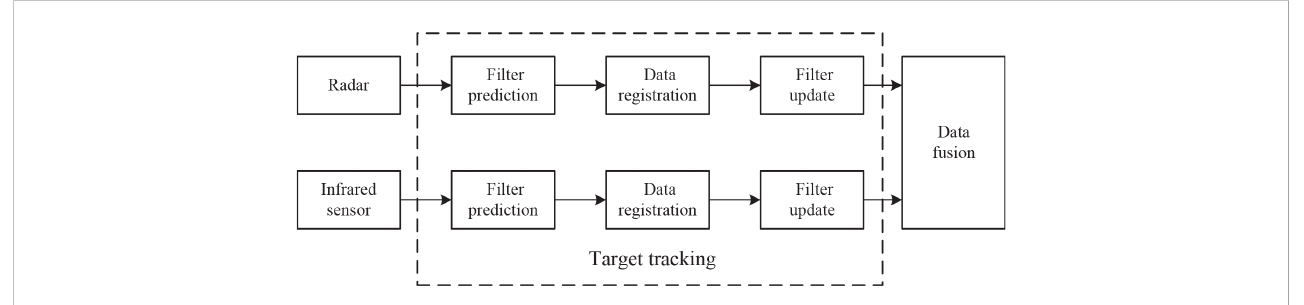
FIGURE 1 A distributed fusion model for radar and infrared